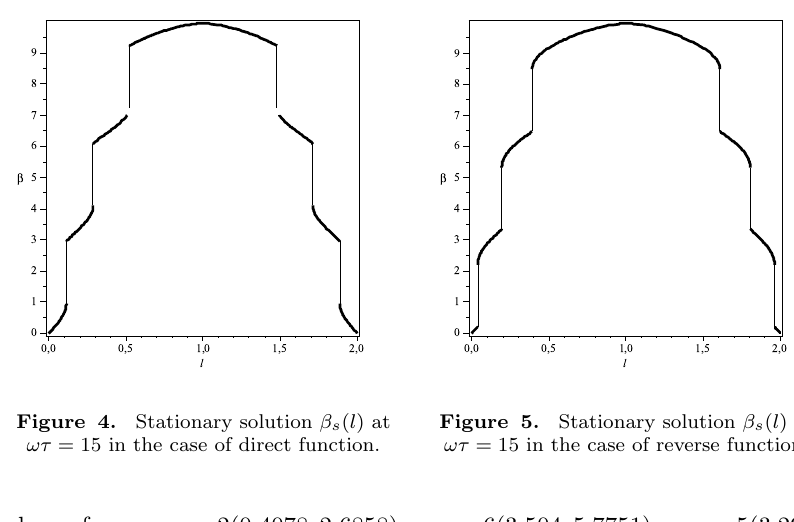
Figure 5. Stationary solution β s ( l ) at ωτ = 15 in the case of reverse